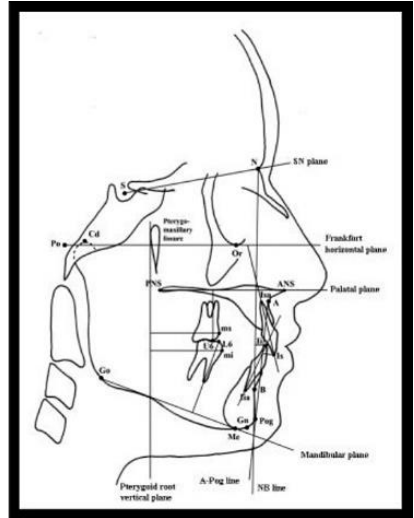
Figure 1. Photograph showing the reference points, angular and linear cephalometric measurements.